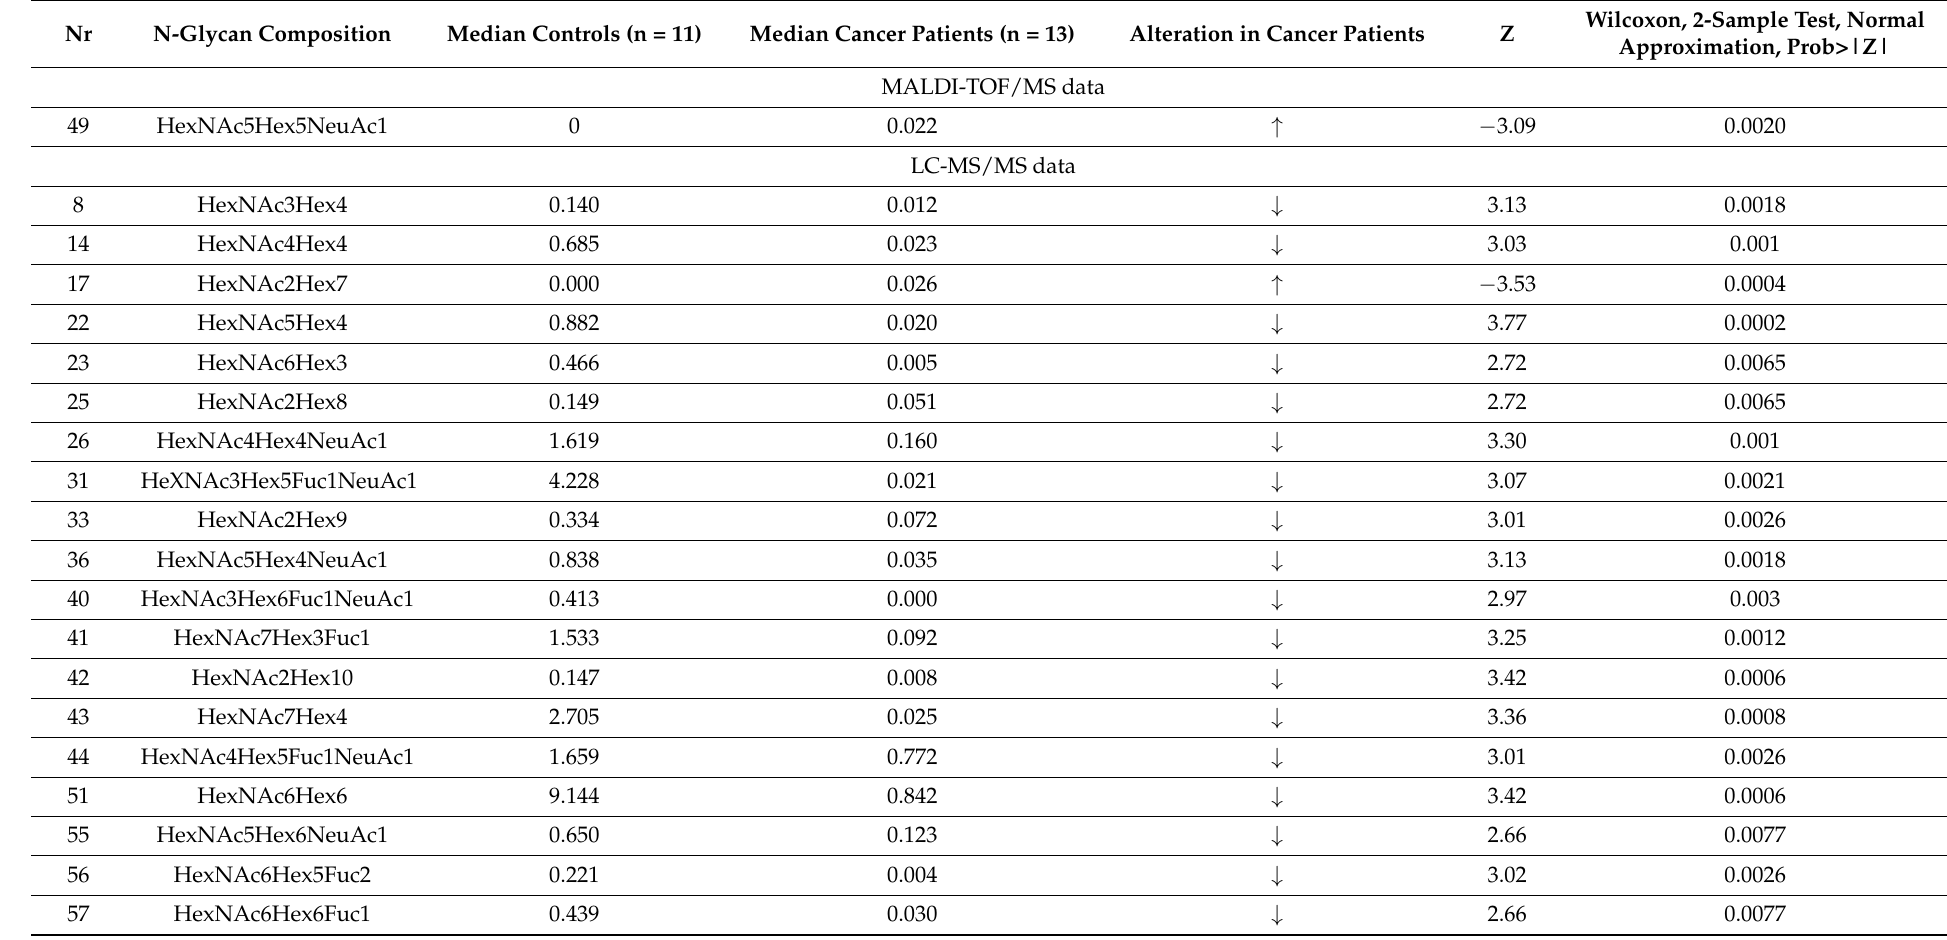
Table 3. Mann–Whitney U tests of the relative concentration of N-glycans in serum of cancer patients and controls obtained by MALDI-TOF/MS and